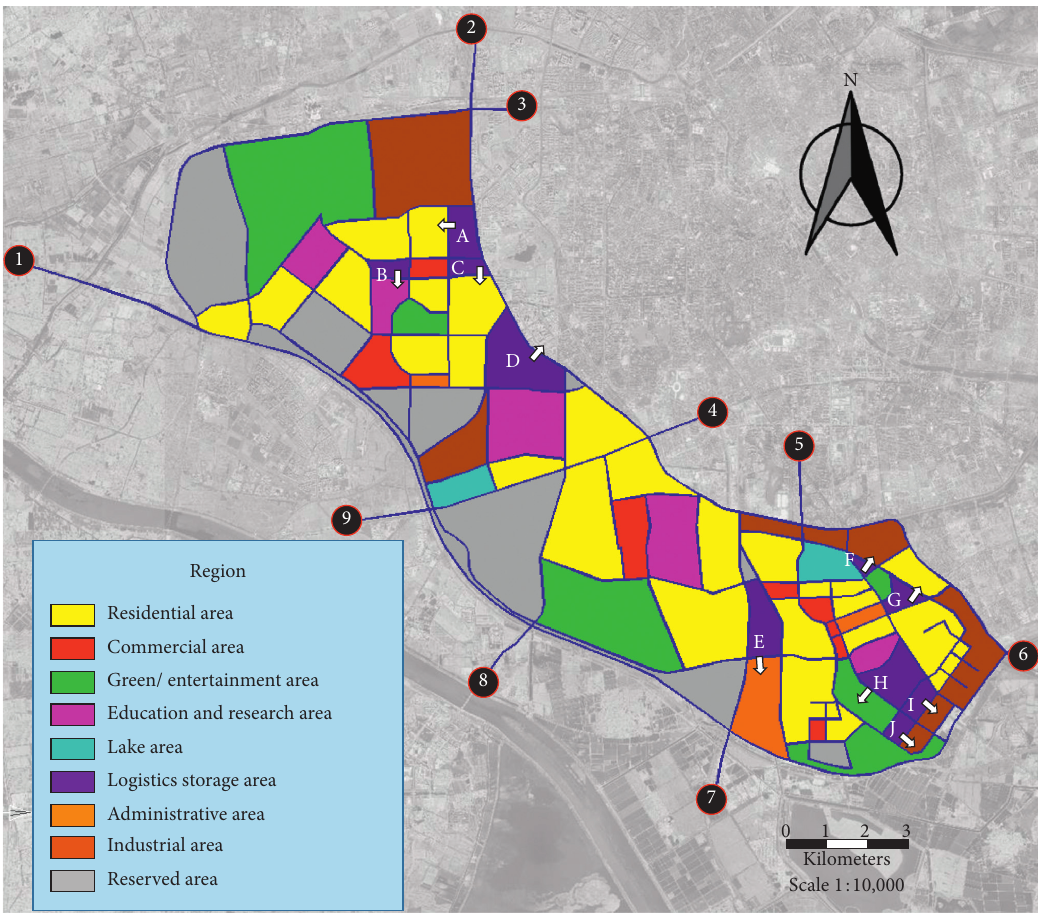
Figure 2: Core area of Xiqing Economic and Technological Development Zone. Table 4: The arrival rate of trucks at each logistics